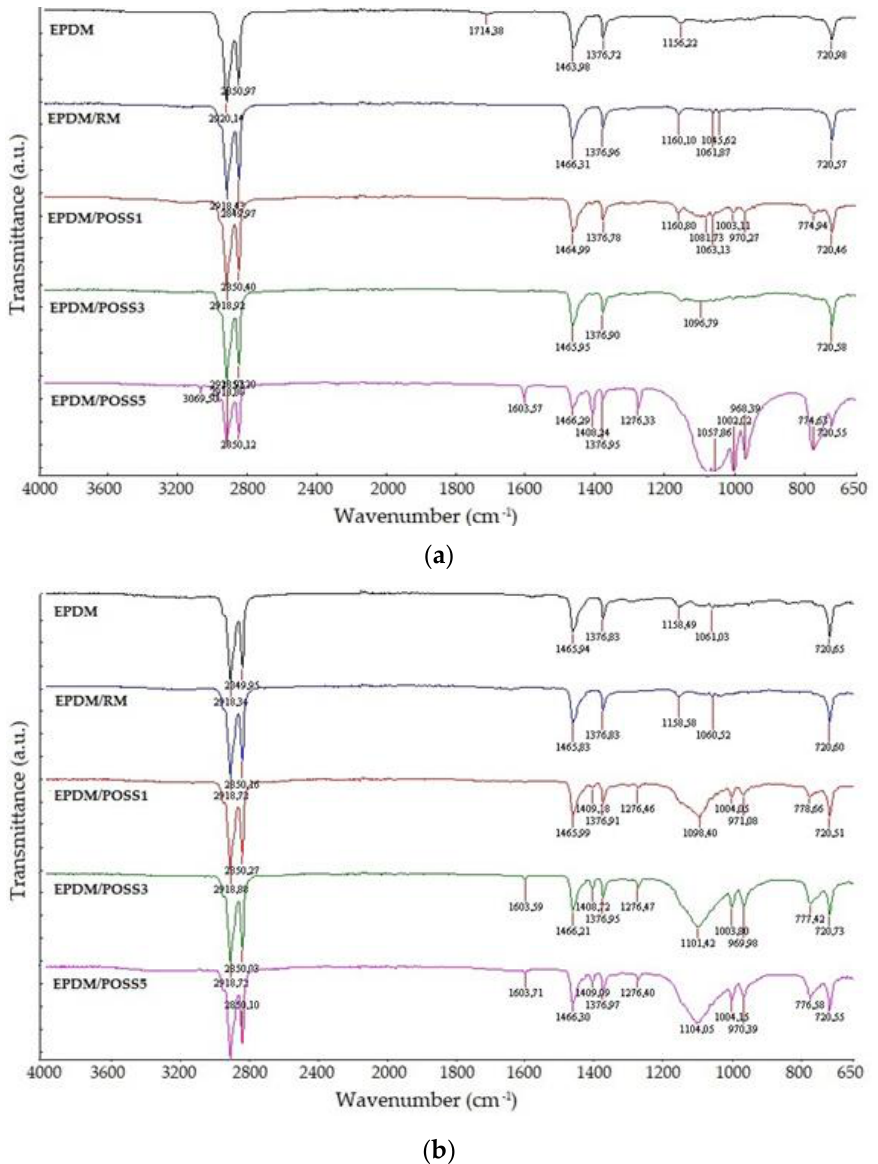
Figure 1. FTIR spectra of studied EPDM formulations. Irradiation doses: ( a ) 0 kGy and ( b ) 50 kGy.